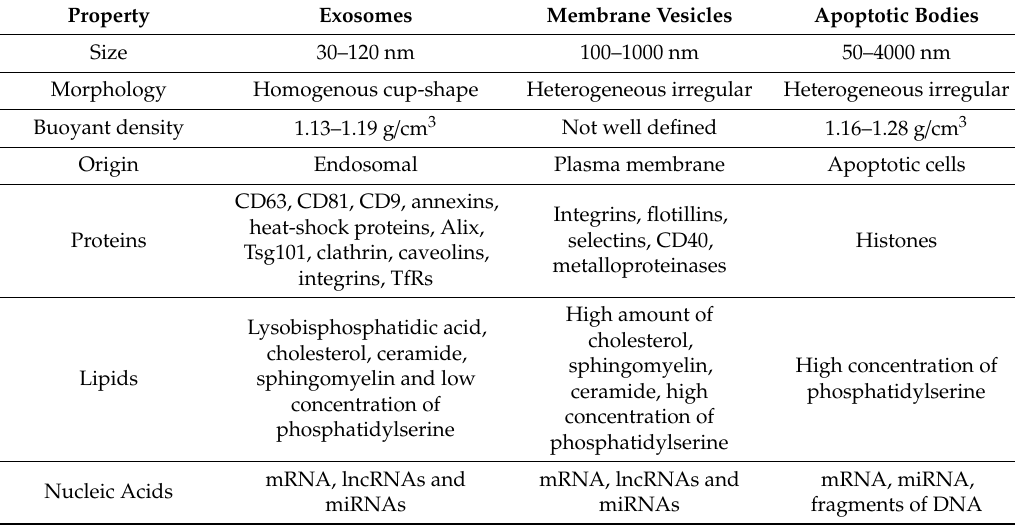
Figure 1. Schematic representation of the three main types of extracellular vesicles released by cells. Table 1. Summary of extracellular vesicles